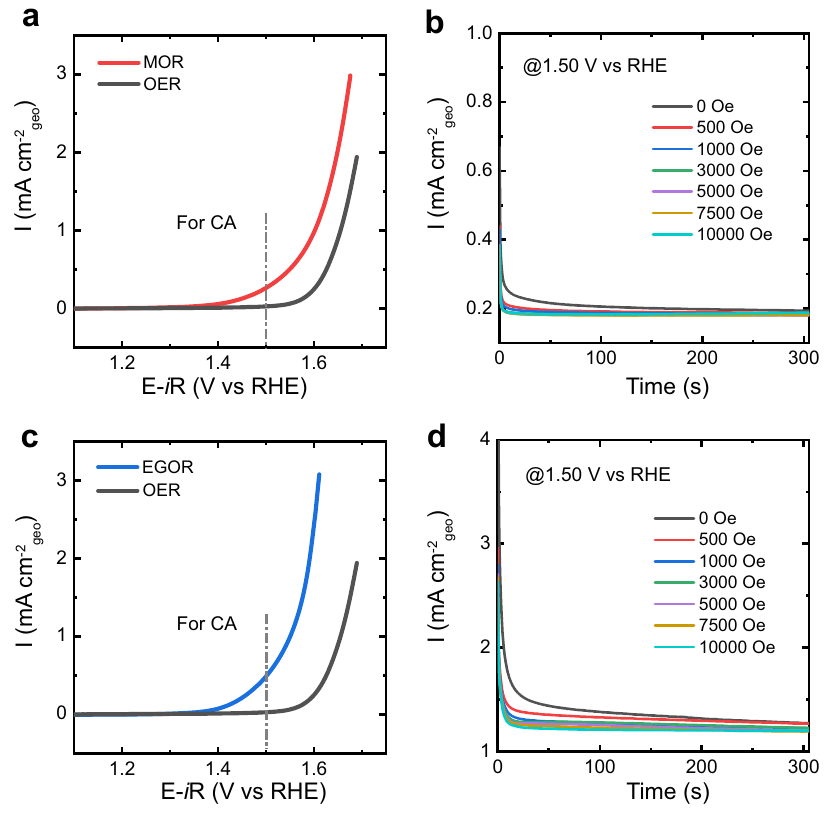
Fig. 5 No in fl uence on MOR and EGOR. a Linear sweep voltammetry (LSV) curves of MOR at a scan rate of 10 mV/s in 1 M KOH in the presence of 1 ml methanol. b Chronoamperometry (CA) experiments of MOR were performed at a constant potential of 1.50 V (versus RHE). c LSV curves of EGOR at a scan rate of 10 mV/s in 1 M KOH in the presence of 1 ml ethylene glycol. d The CA curves of EGOR at 1.50 V vs.